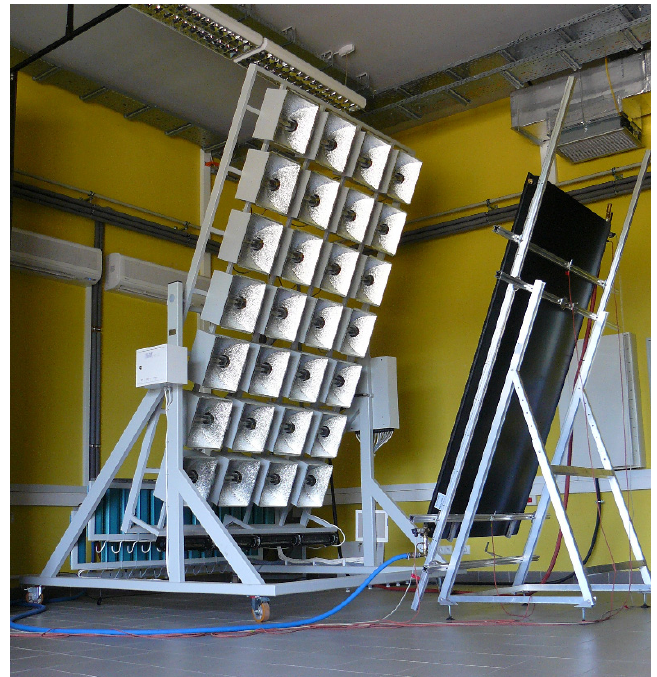
Figure 3. Solar radiation simulator.